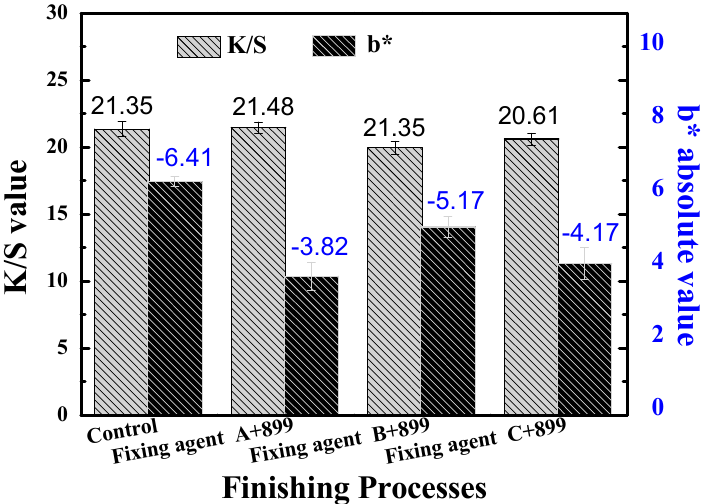
Figure 7. The K / S value and rubbing fastness of softened cotton fiber.